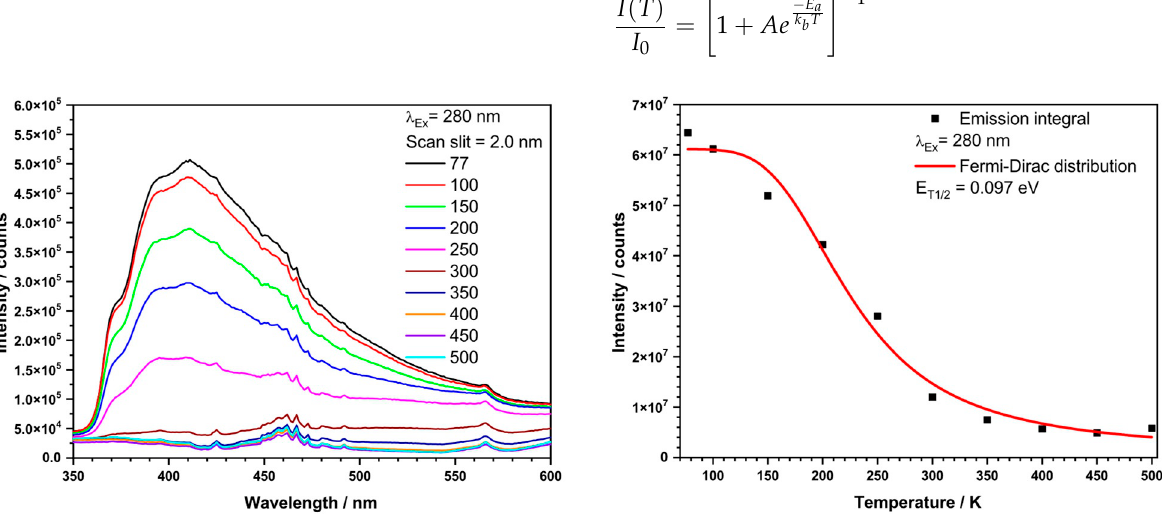
Figure 12. Temperature-dependent emission spectra ( left ) and temperature-dependent emission spectra integrals from 350 to 600 nm ( right ) of Tl[CB 11 H 12 ] under 280 nm excitation between 100 and 500 K.